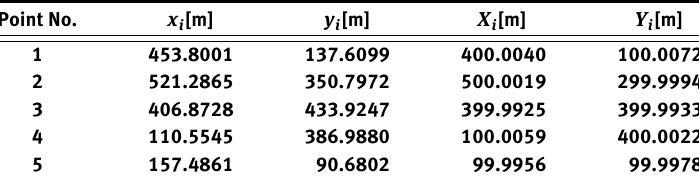
Table 1. Coordinate estimates in source and target systems Point No.